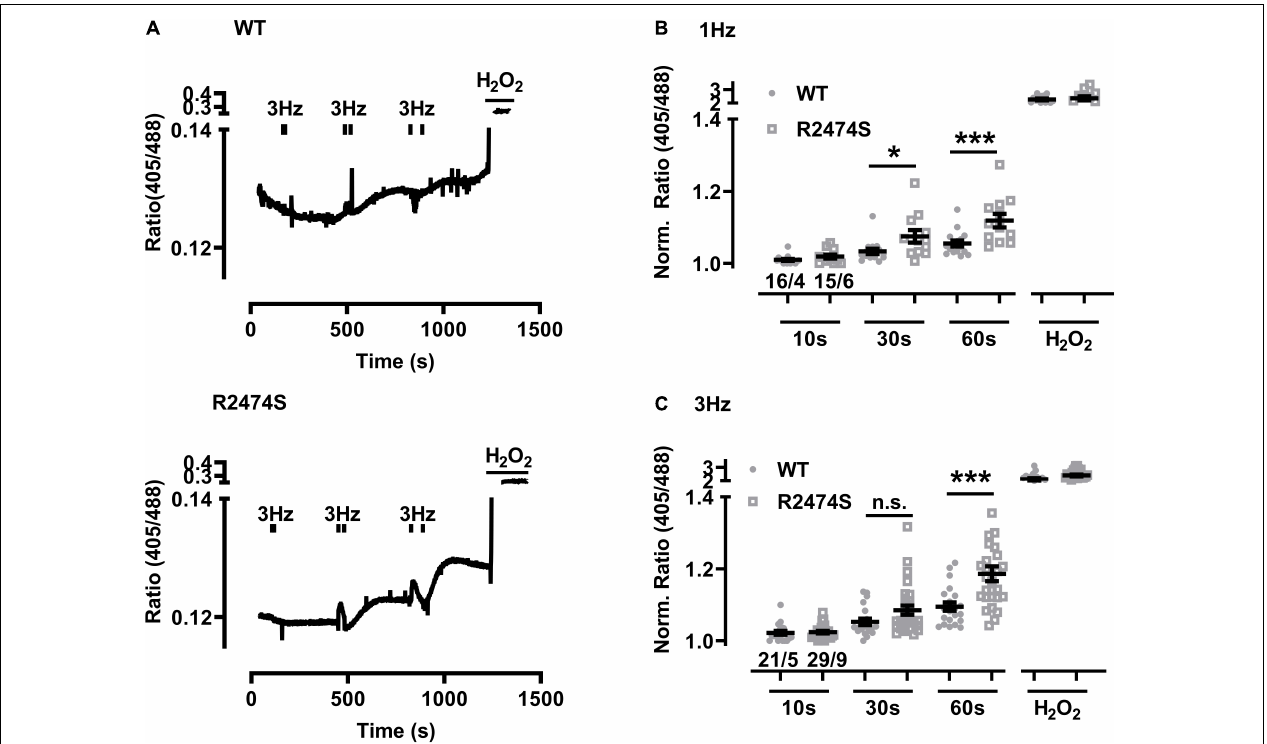
FIGURE 5 | Increased mitochondrial oxidation in RyR2-WT vs. RyR2-R2474S dTG-cardiomyocytes following different beating rates. (A) Representative time course of the I405/I488 nm ratio following 3 Hz beating of RyR2-WT control ( top ) and RyR2-R2474S ( bottom ) dTG-cardiomyocytes. Black bars indicate the start and end of each beating interval lasting 10, 30, and 60 s. H 2 O 2 (200 µ M) was added at the end of each experiment to obtain the maximal oxidized value. (B,C) Dot plots showing individual and mean ± SEM normalized I405/I488 nm ratio values for the indicated durations either at the 1 Hz (B) or 3 Hz (C) beating rate. The fluorescent signal values of each cardiomyocyte were obtained under baseline conditions and after the indicated beating trains each lasting 10 s, 30 s or 60 s. Cell/heart numbers are indicated. Unpaired one-way ANOVA with Tukey’s post-test. *** P = 0.001; * P = 0.03; n.s., non-significant.